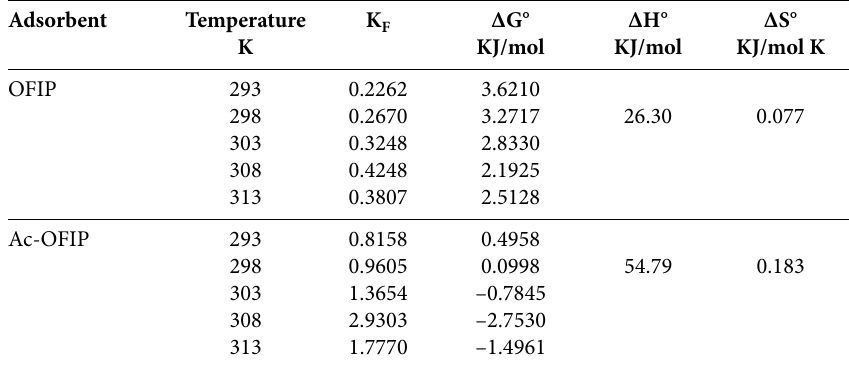
Table 3. Values of thermodynamic parameters of manganese adsorption at different temperatures by OFIP and Ac-OFIP. Adsorbent